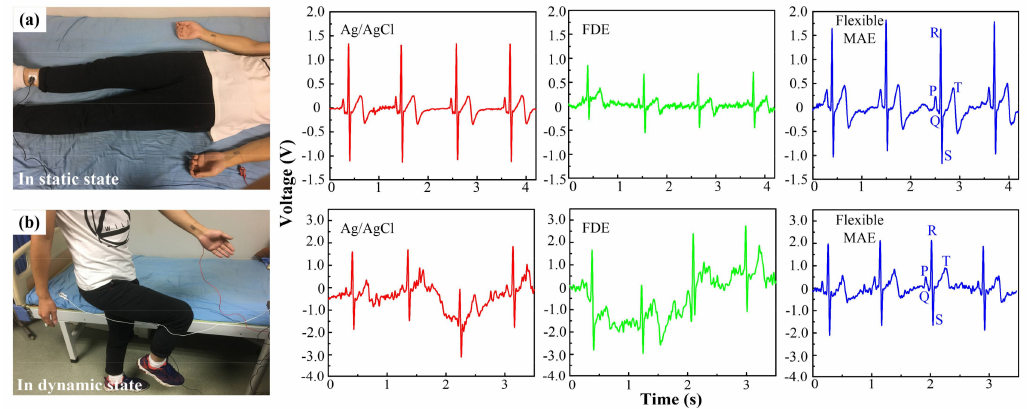
Figure 5. ECG signals recorded by the Ag/AgCl electrode, FDE and flexible MAE: ( a ) in the static state, and ( b ) in the dynamic